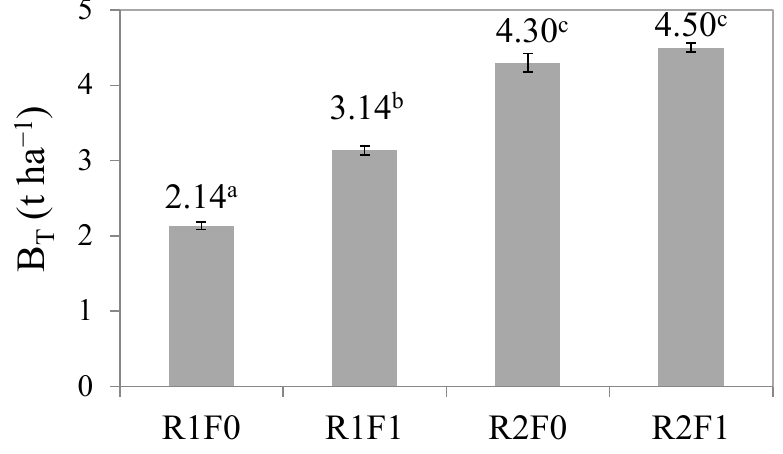
Figure 6. Mean values (± SE) of the total stem biomass at the stand level for the different treatments ( n = 4); values followed by the same letter were not different at the 0.05 level according to the LSD post-hoc test; R1F0: irrigation with 1000 liters/tree without fertilization; R1F1: irrigation with 1000 liters/tree and fertilization; R2F0: irrigation